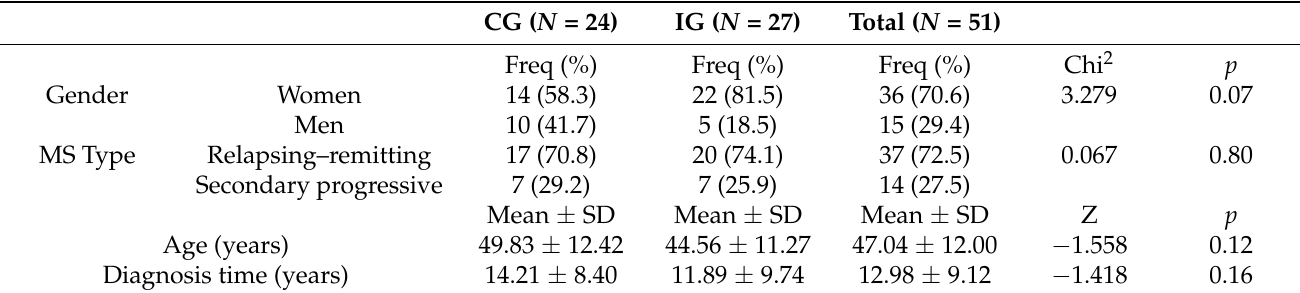
Table 1. Socio-demographic characteristics of the population of the study.